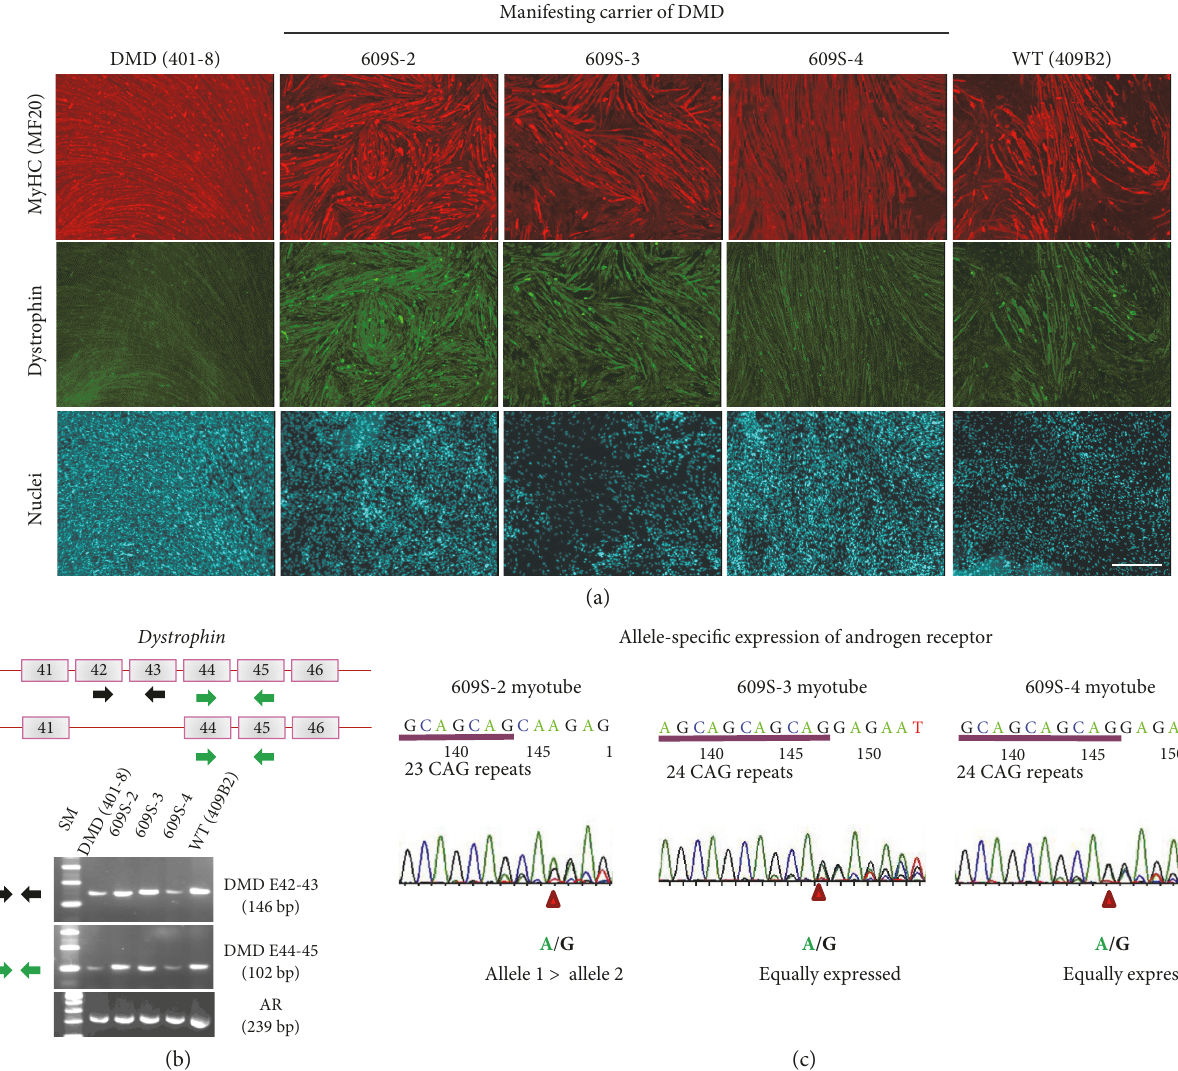
Figure 5: Myotubes derived from XaXa 609-hiPS cells restore normal dystrophin expression and nonskewed expression of the androgen receptor gene. (a) 409B2 iPSCs (normal), DMD-iPSCs (401-8, duplication of exons 45 – 50 of the dystrophin ( DMD ) gene), and manifesting carrier of DMD-iPS clones (609S-2, 609S-3, and 609S-4) were induced to di ff erentiate into multinucleated myotubes. Normal iPS-derived myotubes expressed dystrophin. DMD-iPS-derived myotubes were negative for dystrophin. 609 iPSC-derived myotubes expressed dystrophin at comparable levels with wild-type myotubes. Scale bar: 500 μ m. (b) RT-PCR analysis for dystrophin ( DMD ) and androgen receptor ( AR ) in myotubes derived from 409B2 iPSCs (normal), DMD-iPSCs (401-8), and manifesting carrier of DMD-iPSCs (609S-2, 609S-3, and 609S-4). Primer positions and directions for dystrophin transcripts are indicated by arrows. (c) Direct sequencing of CAG repeats of AR transcripts in myotubes derived from manifesting carrier of DMD-iPS clones (609S-2, 609S-3, and 609S-4). 609S-2 myotubes show allele 1(23 CAG repeats) — dominant expression. In 609S-3 and 609S-4 myotubes, two alleles (23 and 24 CAG repeats) are equally